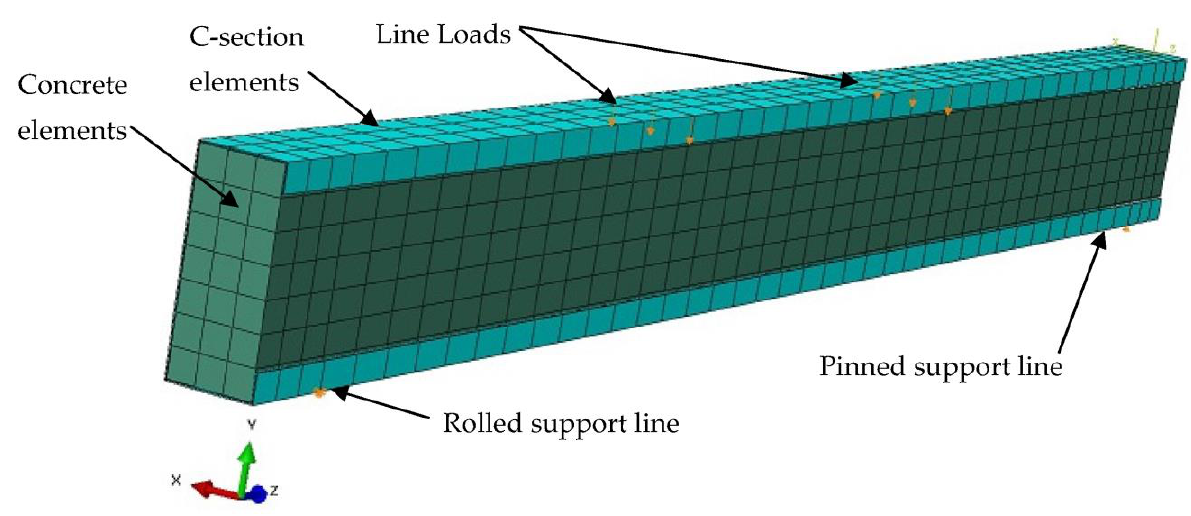
Figure 16. Typical FE model (specimen B-CM0).